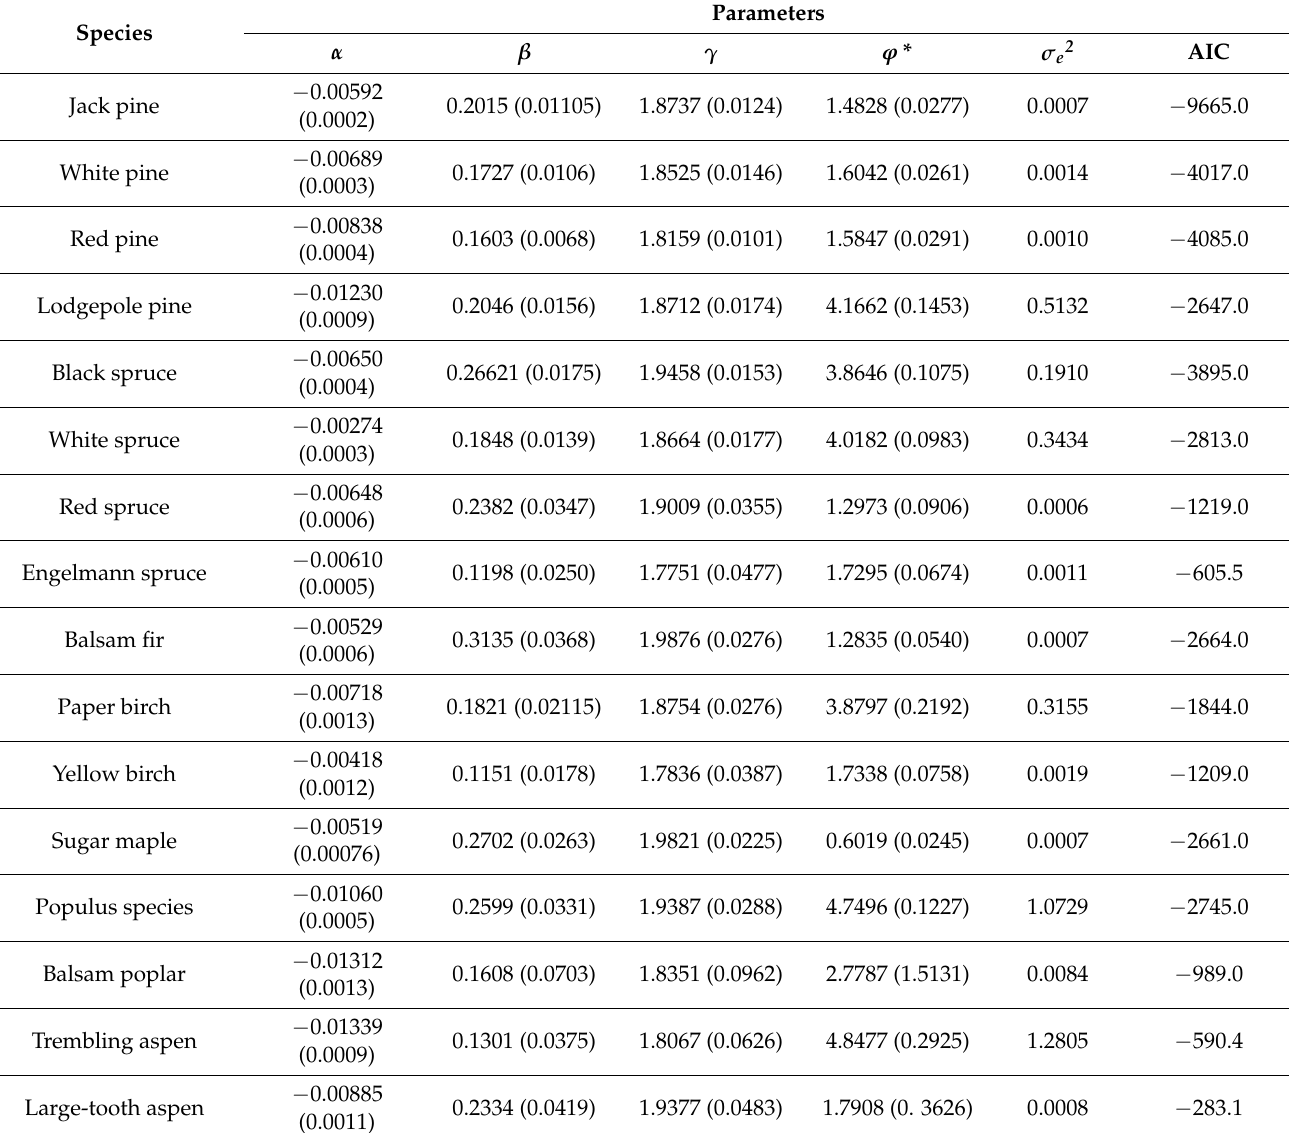
Table 4. Parameter estimates (standard error) and fit statistics (MSE ( σ e 2 ) and AIC (Akaike’s Information Criterion))